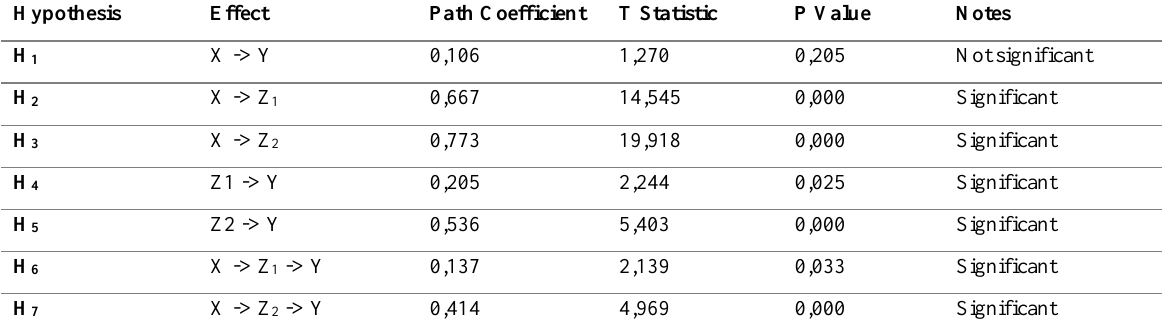
Table 7: Hypothesis Testing